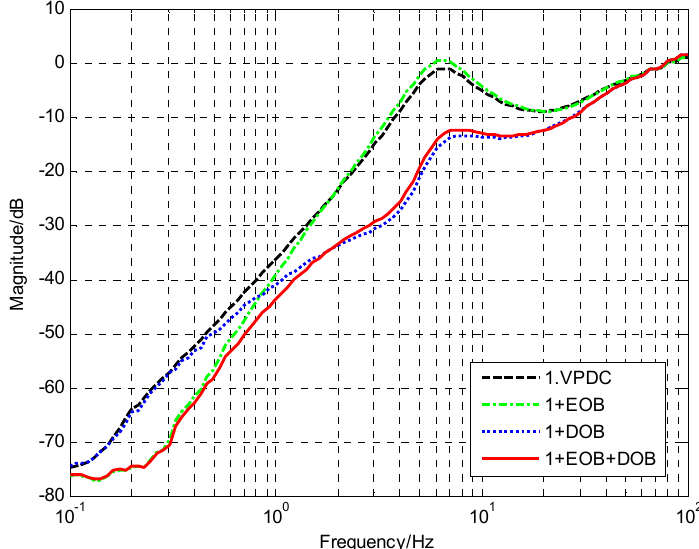
Figure 15. The disturbance suppression response of the MOTS.